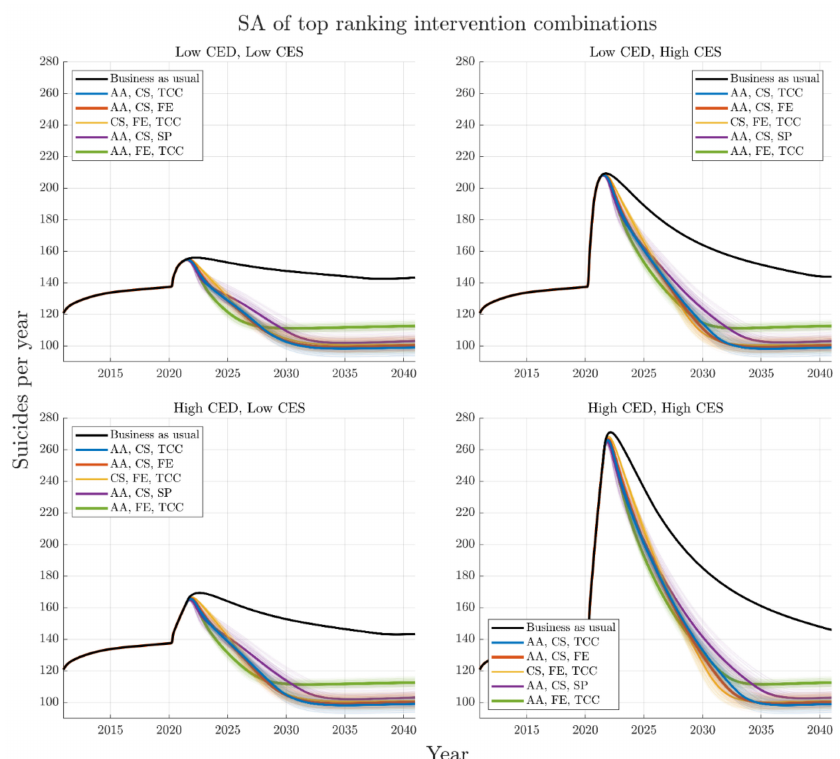
Figure 4. Trajectories for the best performing intervention combinations in reducing suicides deaths over the period 2021–2041 for the four different COVID-19 mental health scenarios: top left, short duration and low impact (Scenario A); top right, short duration and high impact (Scenario B); bottom left, long duration and low impact (Scenario C); bottom right; long duration and high impact (Scenario D). Default parameters are chosen for each intervention. The top three ranking sets of interventions are consistent across COVID-19 scenarios; however, the fourth top intervention combination differs depending on CES. The thick black curve indicates the business-as-usual case, the coloured curves indicate the top performing intervention combinations for reducing cumulative suicides from 2021–2041. Distribution means are indicated with a heavy line, and span of individual trajectories from the 100 runs of the sensitivity analysis are presented. AA is post-suicide attempt aftercare; CS is community support programs to increase community connectedness; SP is safety planning; FE is family education and support; TCC is technology-enabled care